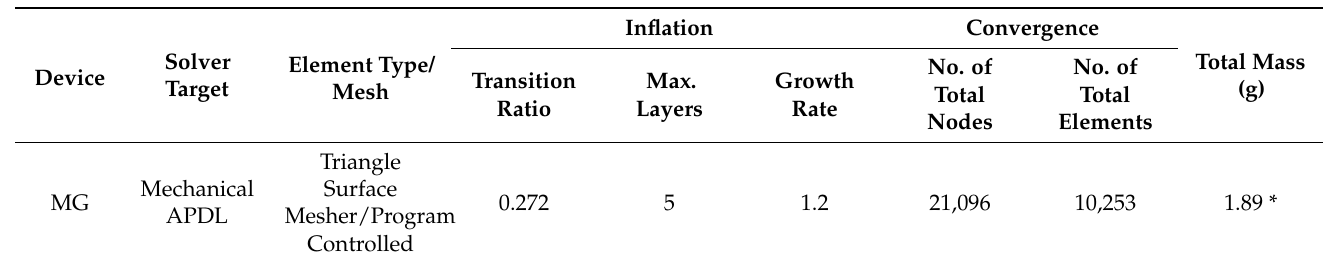
Table 5. Technical details of FEA.